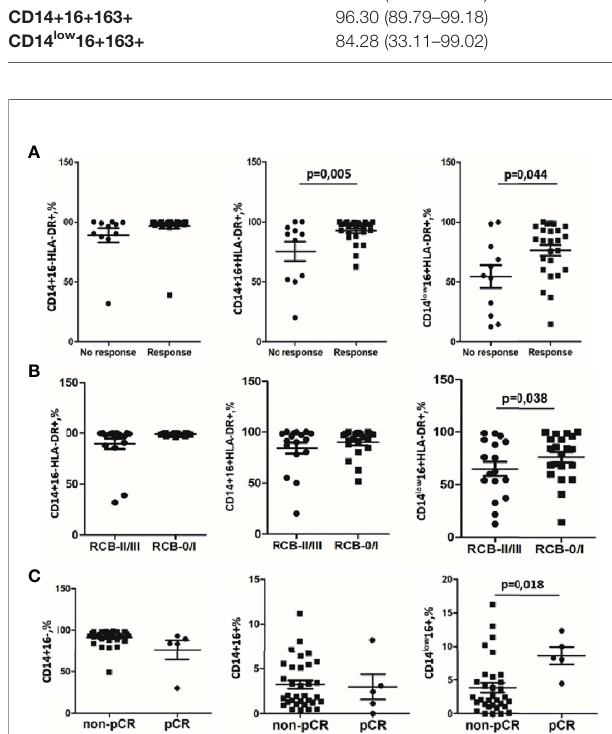
FIGURE 5 | Monocyte subpopulations before treatment are sensitive indicators for NAC response. (A) Strong signi fi cant difference between the group with clinical response to NAC and the group without response to NAC detected by the RECIST 1.1 scale was found for CD14+16+HLA-DR+ and CD14 low 16+HLA-DR+. (B) CD14 low 16+HLA-DR+ subset decrease in the group of patients with RCB II/III vs. RCB 0/I. (C) CD14 low 16+ monocytes correlate with pCR. Statistical analysis was performed by the Wilcoxon test.